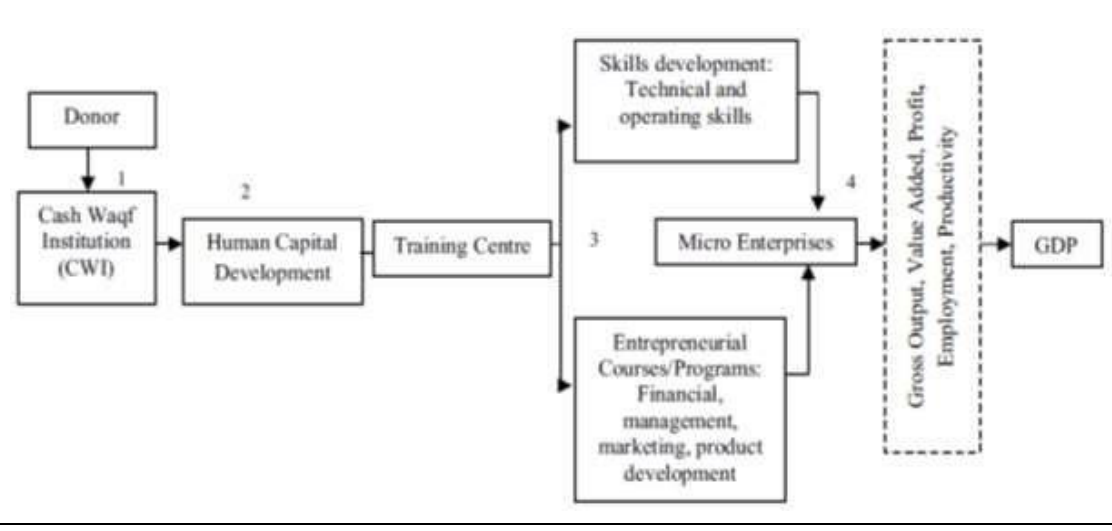
Figure 2: Human Capital Development Through Cash Waqf